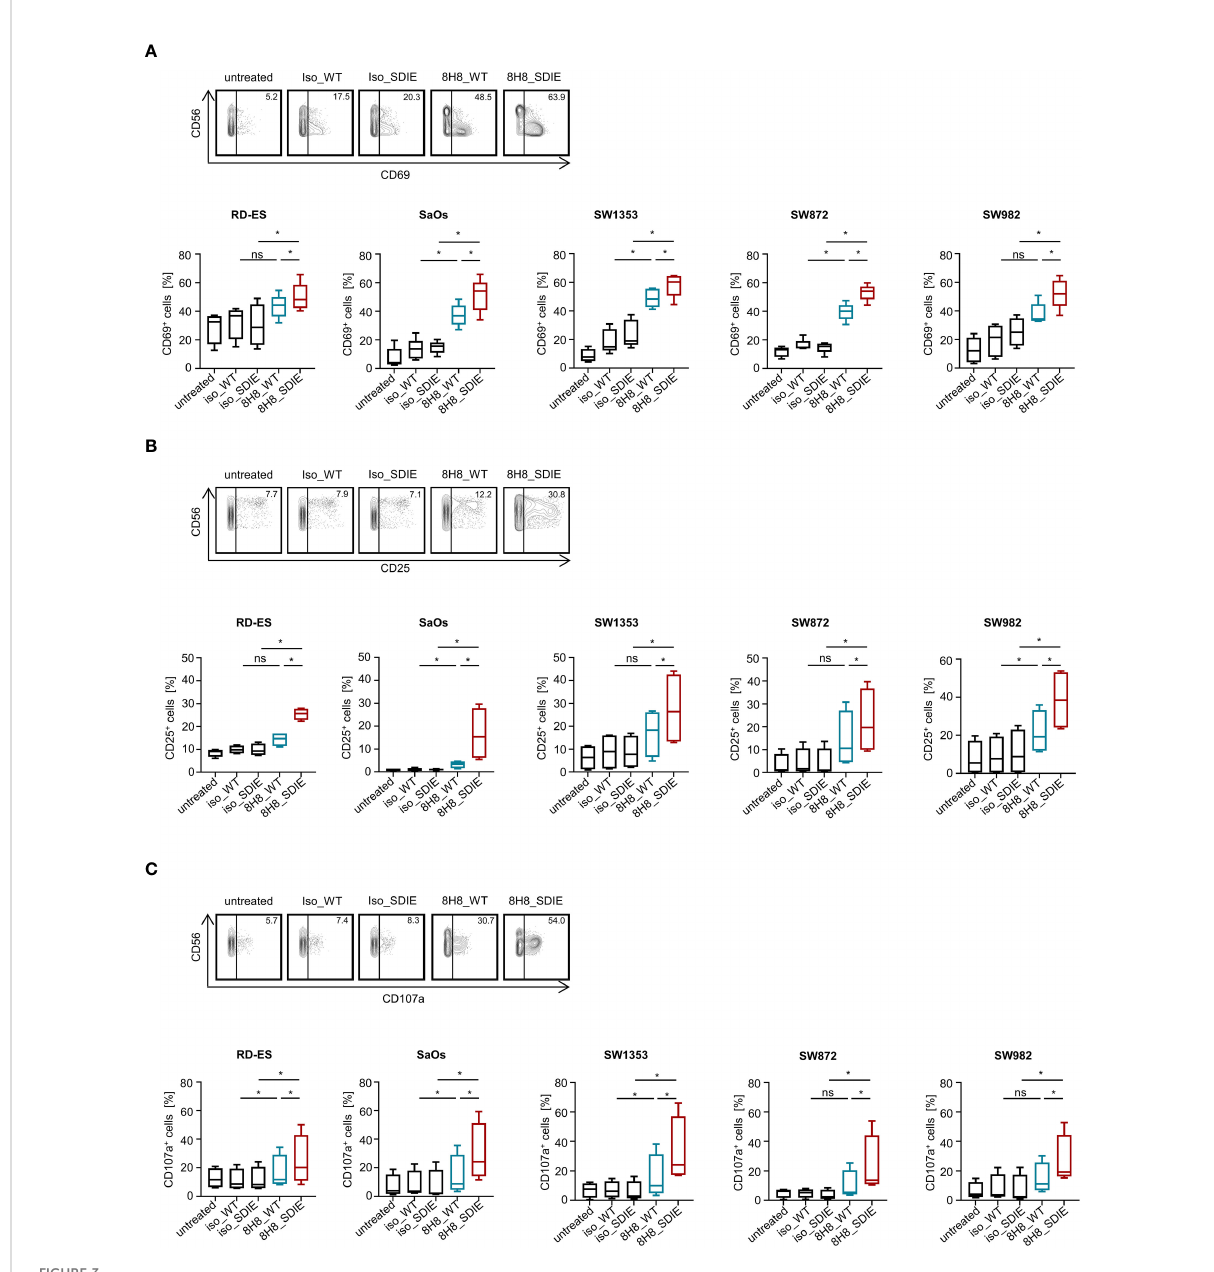
FIGURE 3 Induction of NK cell reactivity by B7-H3 antibodies against sarcoma cells. PBMC of healthy donors were cultured with or without sarcoma cells at an E:T ratio of 2.5:1 in the presence or absence of B7-H3 antibodies or the corresponding isotype controls (1 m g/mL). (A) Activation of NK cells was determined by expression of CD69 after 24h. In the upper panels, exemplary fl ow cytometry results obtained with SaOs and in the lower panels data for sarcoma cell lines RD-ES, SaOs, SW1353, SW872 and SW982 (n=5) with PBMC of 4 different donors are shown. (B) Activation of NK cells was determined by expression of CD25 after 72h. In the upper panels exemplary fl ow cytometry results obtained with RD- ES and in the lower panels data with sarcoma cell lines RD-ES, SaOs, SW1353, SW872 and SW982 with PBMC of 4 different donors are shown. (C) Degranulation of NK cells was determined by expression of CD107a after 4h. In the upper panels exemplary fl ow cytometry results obtained with SW872 and in the lower panels data with sarcoma cell lines RD-ES, SaOs, SW1353, SW872 and SW982 with PBMC of four independent donors are shown. ns, not signi fi cant; *statistically signi fi cant differences (p-value <